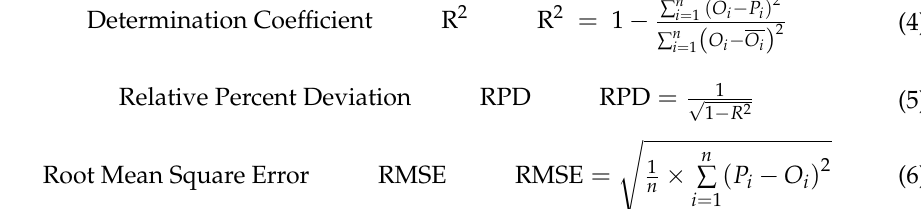
Figure 3. Dynamic changes in leaf RGB values with high, medium, or low nitrogen supplies in YJ4227 after anthesis. 0 R G B N3 Figure 4. Dynamic changes in leaf RGB values with high, medium, or low nitrogen supplies in CY5 after anthesis.